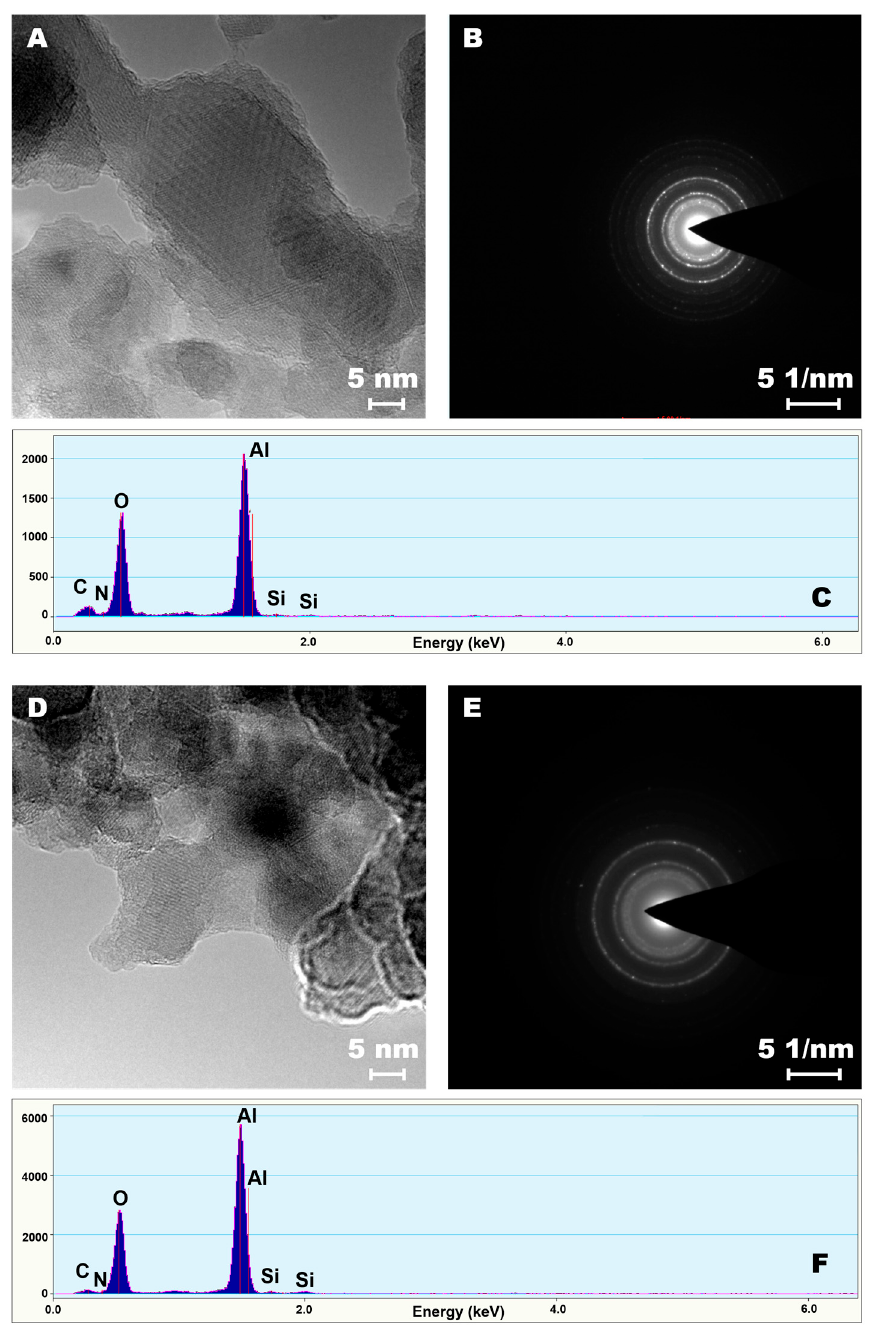
Figure 3. HR-TEM—bright field ( A , D ), selected electron area diffraction (SEAD) images ( B , E ) and EDX spectra ( C , F ). A, B, C—sample modified with C 4 H 8 NH 2 , D, E, F —sample functionalized with C 4 H 8 NH 2 and enzymes.